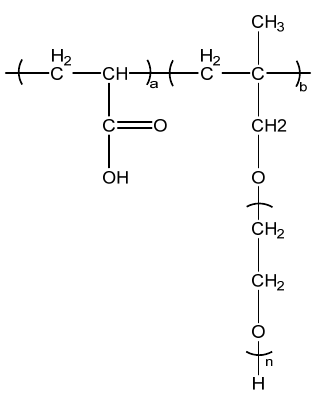
Figure 1. Chemical structures of the PCE.